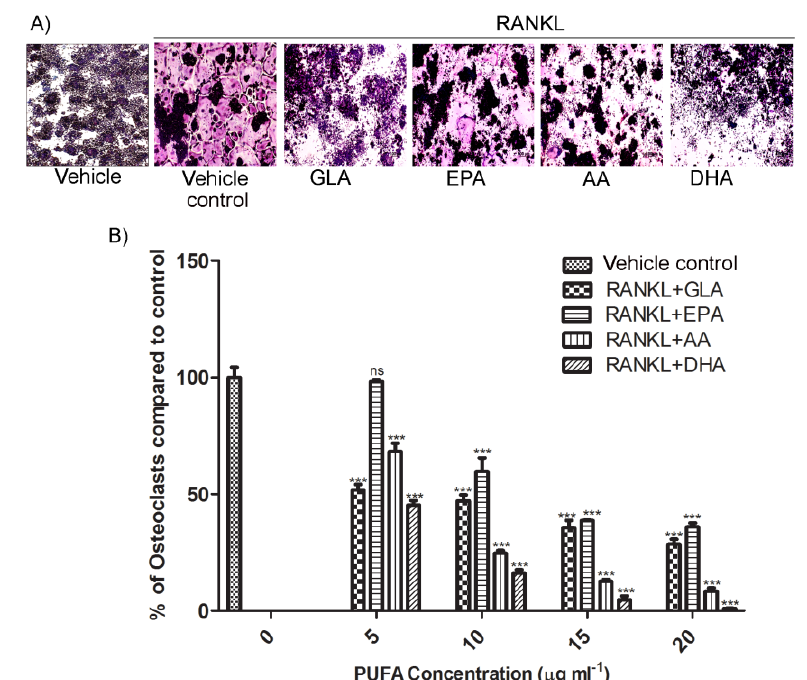
Figure 1. Effects of polyunsaturated fatty acids (PUFAs) on RANKL-stimulated osteoclast formation. ( A ) RAW264.7 murine macrophages cultured for 5 days with vehicle alone, with RANKL (15 ng·mL −1 ) or with various PUFAs: GLA, EPA, AA and DHA (20 μg·mL −1 ) in combination with RANKL are indicated. TRAP-positive cells that contain more than 3 nuclei were counted as osteoclasts. Osteoclasts stain purple-red in the presence of TRAP and appear as large multinucleated cells (MNCs). ( B ) The number of TRAP-positive MNCs as seen in ( A ) were counted in each well and expressed as percentage of TRAP-positive MNCs in the vehicle control. Statistical analysis was performed by two-way ANOVA followed by Bonferroni post hoc test. Three independent experiments were performed and each value represents the mean ± SEM of triplicate cultures; one representative field of view is shown for each exposure. ( *** Significant difference from RANKL-control, p < 0.001; ( n = 3), ns: no